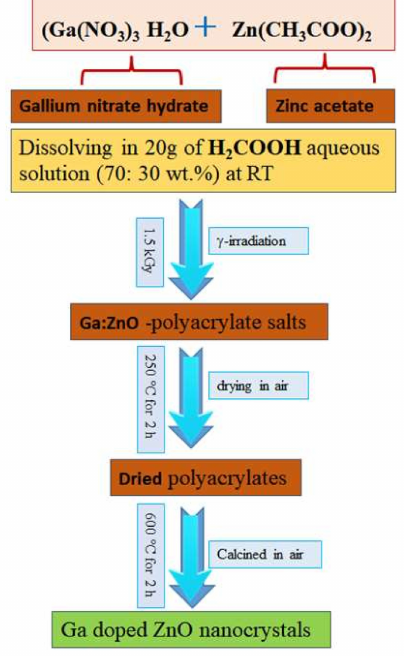
Figure 1. The schematic diagram of synthesis process of Ga doped ZnO nanocrystals using γ -radiation- assisted polymer-pyrolysis